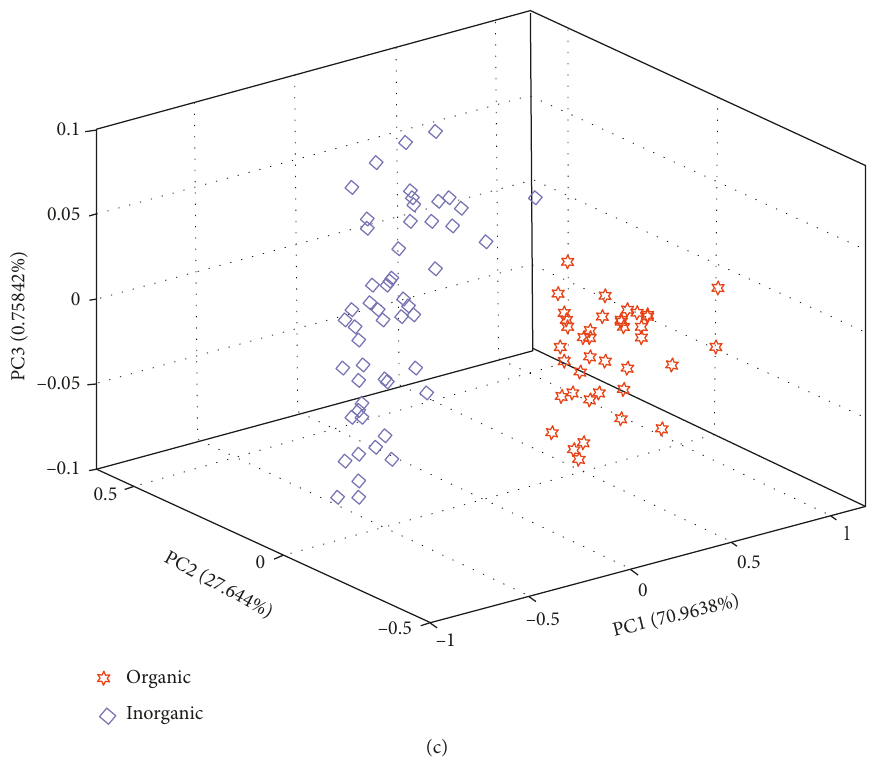
Figure 3: PCA score plot of spectra data. (a) Raw, (b) preprocessed with MC, and (c) preprocessed with MSC. MSC with PCA technique gave a separation with clear cluster